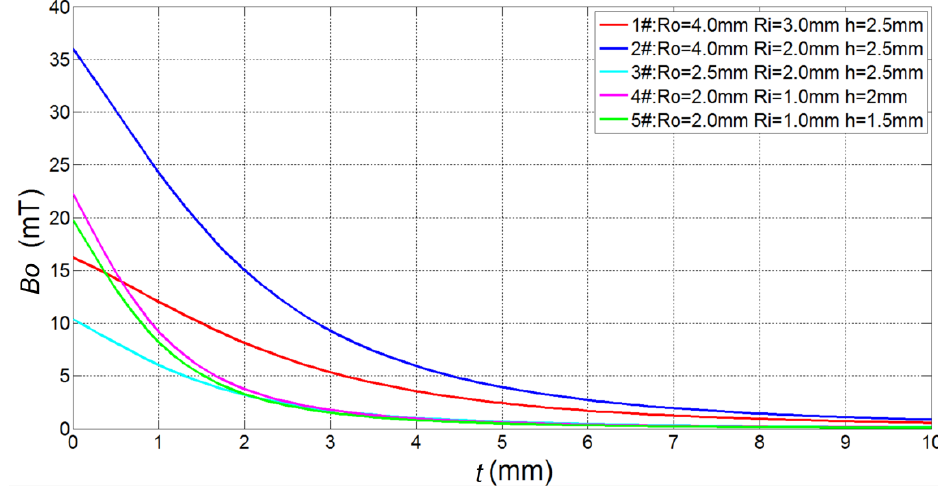
Figure 3. The relationship curves between magnetic induction intensity and lift-off.